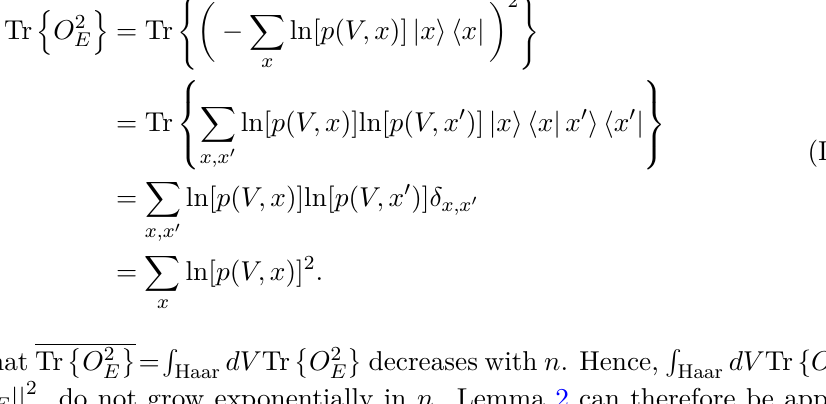
conditions of lemma 2. First, we can show that || O R dV || O Haar